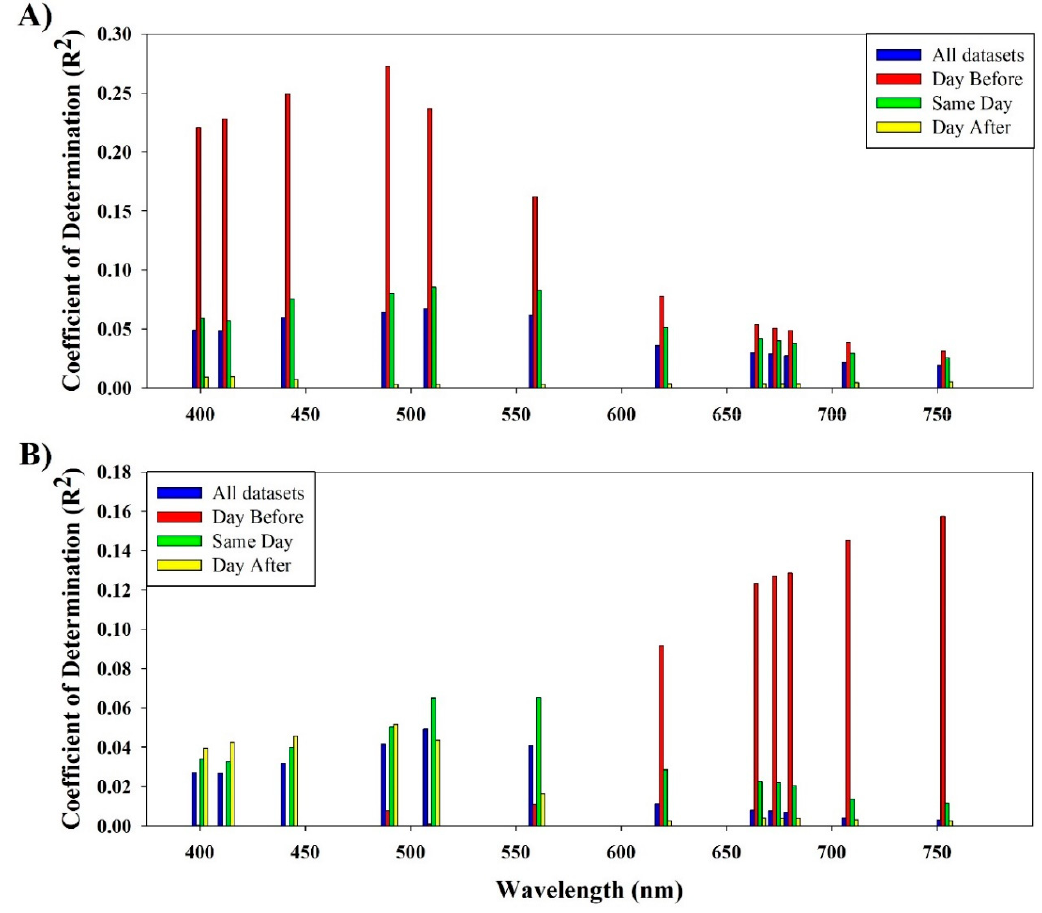
Figure 3. Determination coefficient (R 2 ) values for a linear relationship between each OLCI’ spectral band and ( A ) Phycocyanin (PC) concentrations and ( B ) Chlorophyll- a (Chl- a ) concentration.